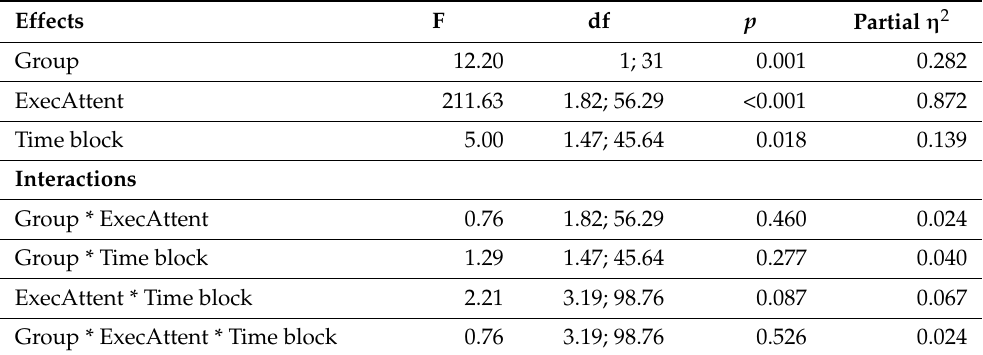
Table 3. Reaction time analysis with factors Group, ExecAttent, and Time block: F, df (Greenhouse- Geisser corrected for within-subject effects), p and partial Eta 2 . Non-integer df represent Greenhouse- Geisser adjusted degrees of freedom.